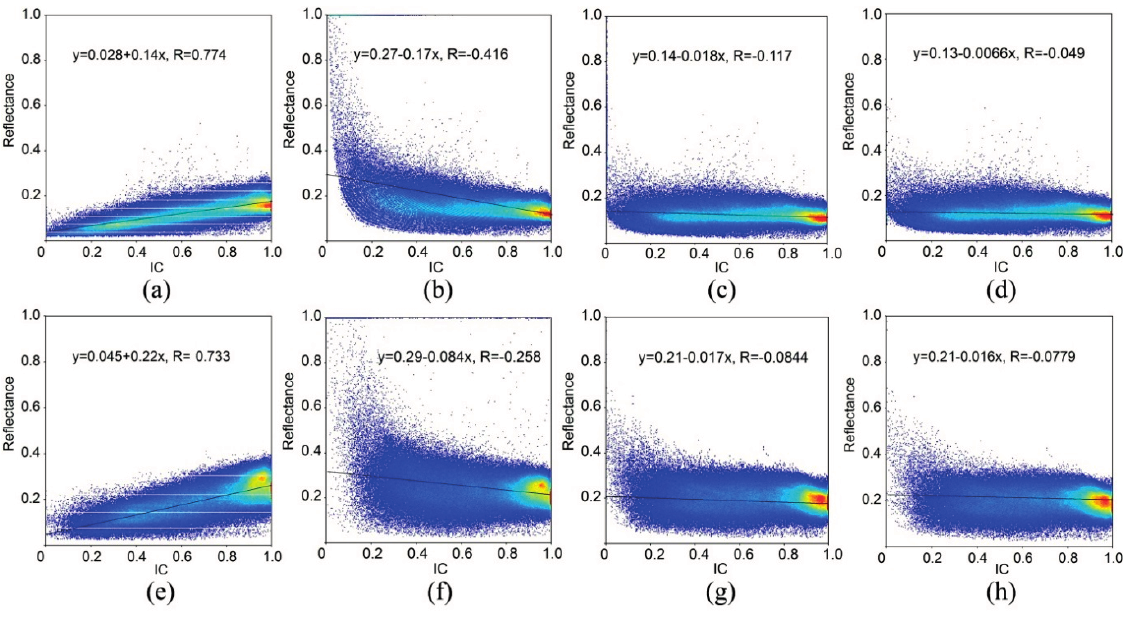
Figure 5. Scatter plots between NIR band reflectance and illumination condition (IC). ( a ) is spring TM scene before correction; and ( b – d ) are correction results by Sandmeier model, Li model and model proposed, respectively. ( e ) is autumn TM scene before correction; and ( f – h ) are correction results by Sandmeier model, Li model and model proposed,